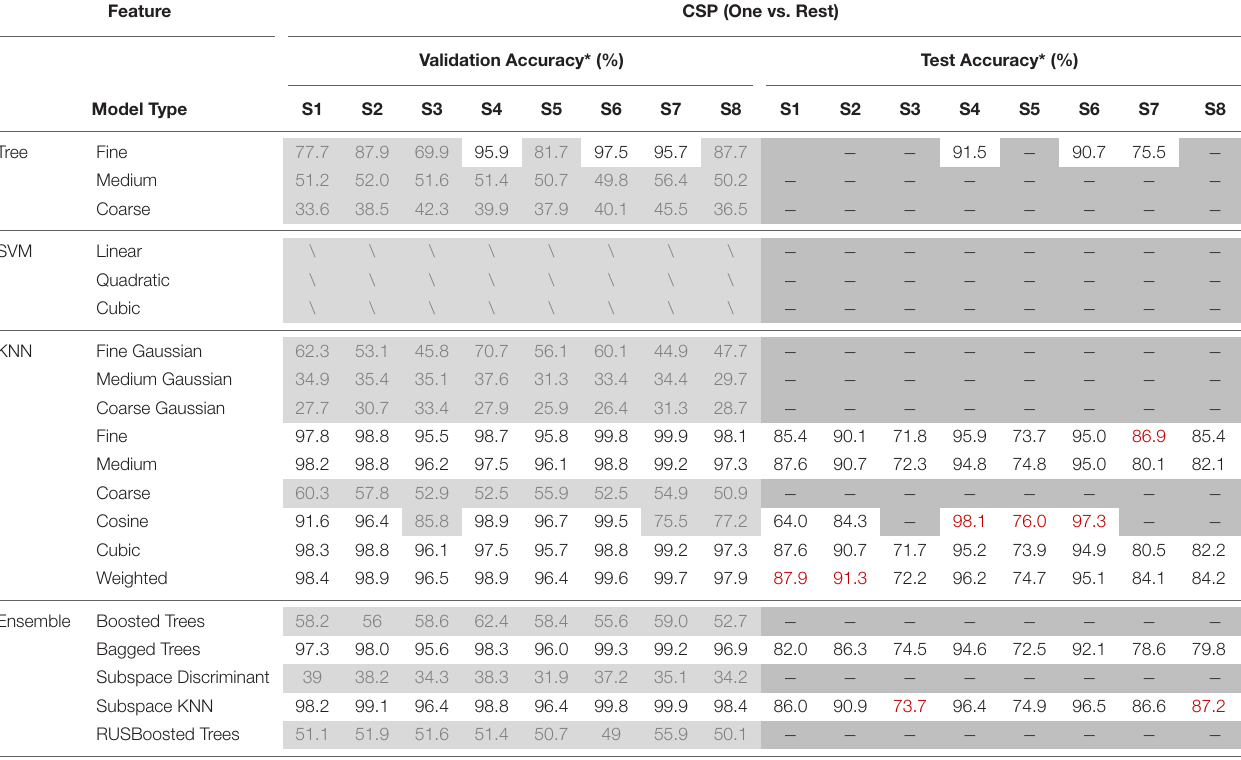
TABLE 8 | The validation and test performances under “training with fake EEGs augmented.”